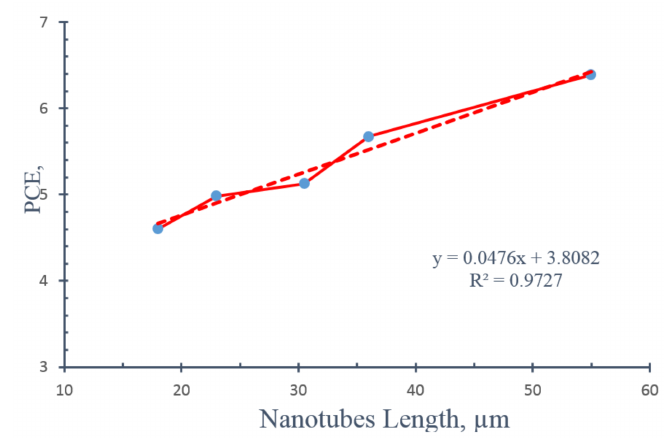
Figure 12. Effect of nanotube length on photoconversion Efficiency, PCE, as a function of applied potential.